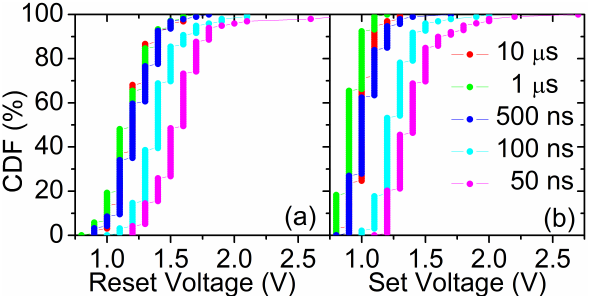
Figure 3. CDFs of the reset ( a ) and set ( b ) voltage amplitudes required by the ISPVA during the first endurance cycle regarding to the programming pulse width used: 10 µ s, 1 µ s, 500 ns, 100 ns and 50